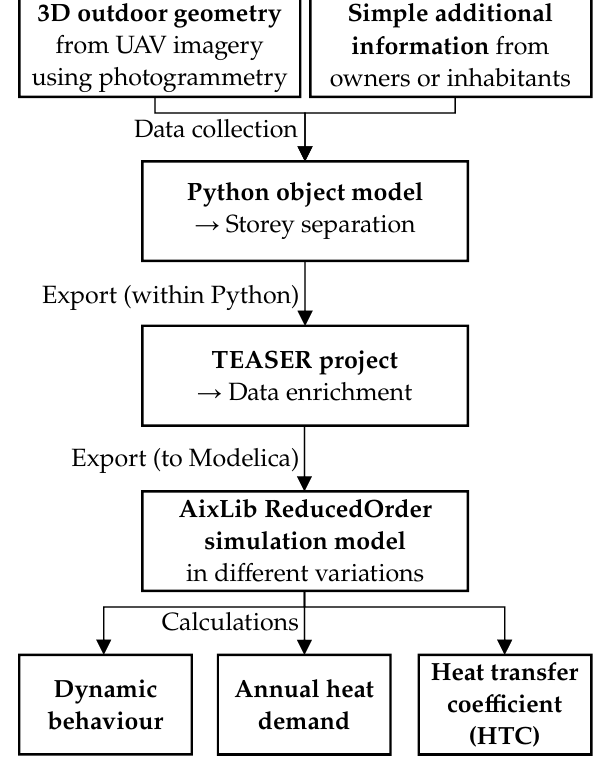
Figure 1. Steps of the approach presented in the study: Generating a building energy simulation model from UAV (unmanned aerial vehicle) imagery and using it for case study calculations.